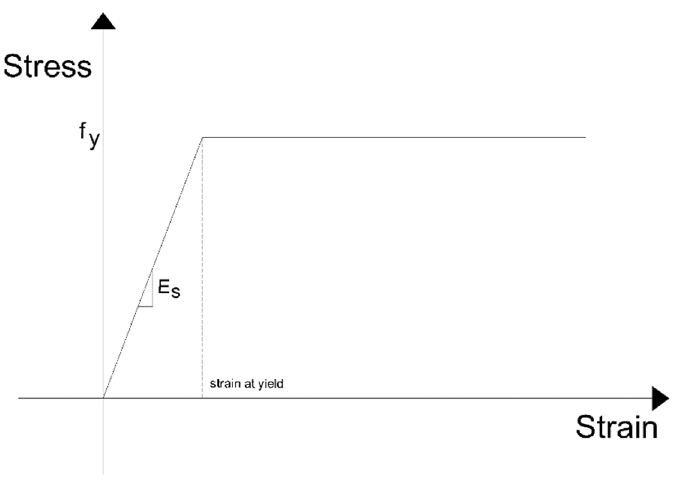
Figure 7. Constitutive law for steel reinforcement (Adapted from Refs. [19,20]).